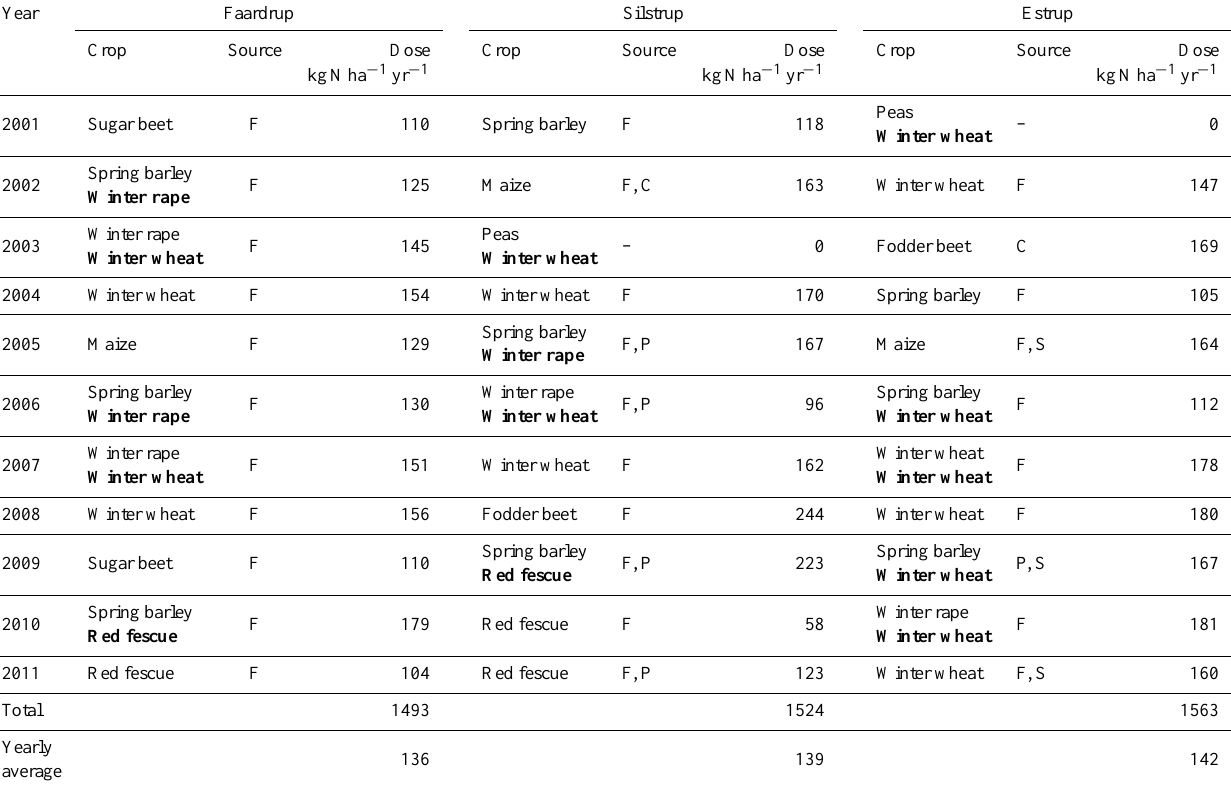
Table 4. Crops and winter cover crops (in bold), crop rotation, types of N-source (F: inorganic fertilisers; C: cattle manure, S: sow manure and P: pig manure), and the amount of N fertilisers (kgNha − 1 yr − 1 ) applied in 2001–2012 at Faardrup, Silstrup and Estrup.